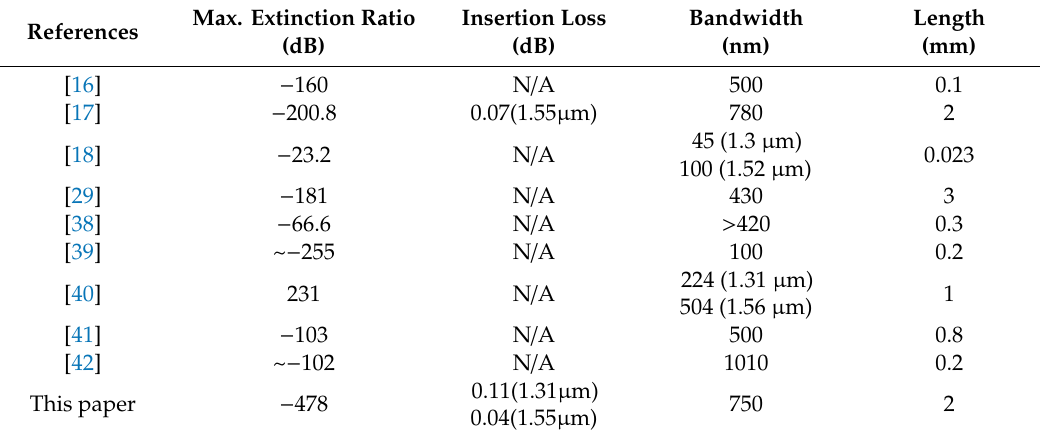
Table 2. Performance comparison between the proposed filter and prior filters.